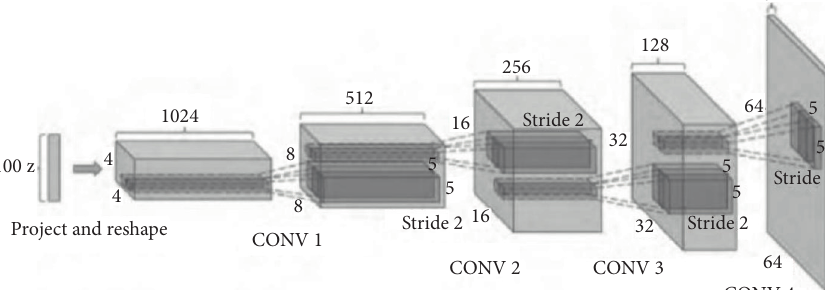
Figure 5: Implementation of inverse convolutional neural network.